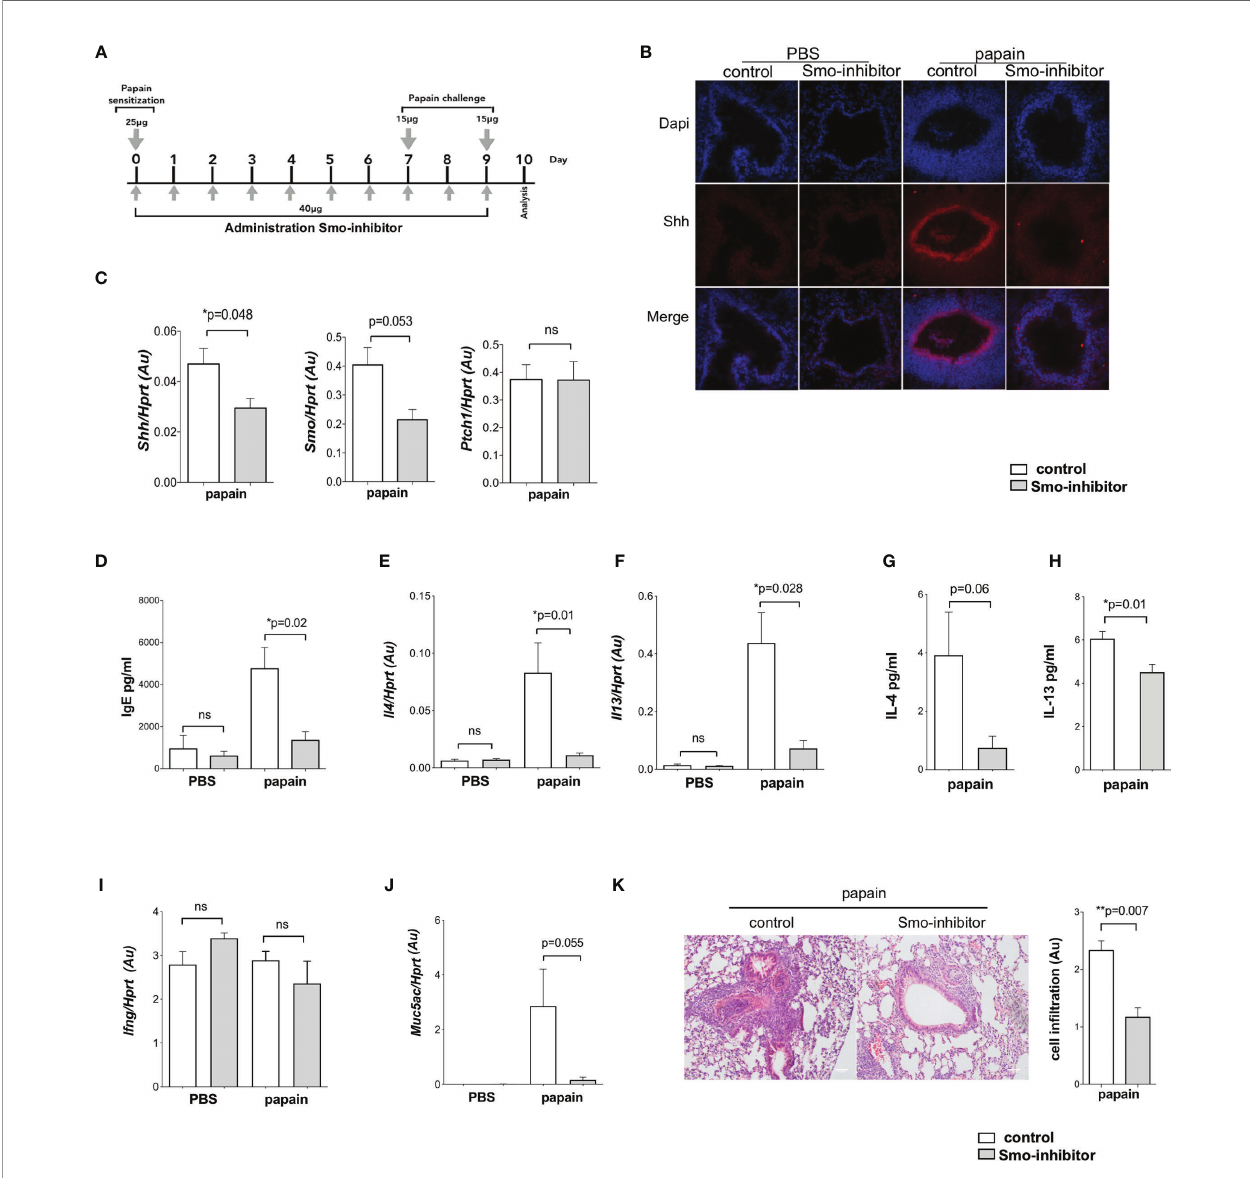
FIGURE 1 | Systemic smoothened-inhibitor treatment reduced the expression of Hh pathway components and the in fl ammatory response upon allergic sensitization. (A) Cartoon illustrates the papain protocol: mice underwent intranasal administration of papain or PBS alone on days 0, 7, and 9, together with a daily intraperitoneal injection of Smo inhibitor or DMSO (control) according to the timeline and doses shown. (B) Representative immuno fl uorescence staining images of Shh expression (red) and DAPI-stained nuclei (blue) in frozen lung sections from the four groups of mice (n = 3 per group). (C) Expression (QRT-PCR) of Shh (n = 5), Smo (n = 3), and Ptch1 (n = 5) in lung homogenates from control and Smo-inhibitor-treated groups after the papain protocol. (D) Blood serum IgE (ELISA) from the four groups of mice. (E) Il4 and (F) Il13 gene expression (mean ± SEM) in lung homogenates of control and Smo-inhibitor groups from PBS and papain protocol by QRT-PCR. (G, H) Protein level of (G) IL-4 and (H) IL-13 measured by ELISA from lung homogenates under papain treatment. (I) Plot shows the expression of Ifng lung homogenates of control and Smo-inhibitor groups from PBS and papain protocol by QRT-PCR. (J) Expression of Muc5ac from lungs under different conditions. (K) Representative images showing cellular in fi ltration in H&E-stained lung sections from control and Smo-inhibitor groups following the papain protocol, ×20 objective lens (Plan-Neo fl uar/0.5NA). Bar chart: mean ± SEM score on scale of cellular in fi ltration of airways, from 0 (normal) to 3 (strong in fi ltration) (arbitrary units) (n = 3). Scale bar: 50 µm. For PBS groups n = 5 and papain-treated groups n = 6; for (F, I) : PBS groups n = 5; papain- treated group n = 3; *p < 0.05, **p < 0.01 unpaired Student ’ s t-test. Data shown are from a representative experiment, and n numbers represent individual mice (biological replicates) in the experiment shown. n.s., not signi fi